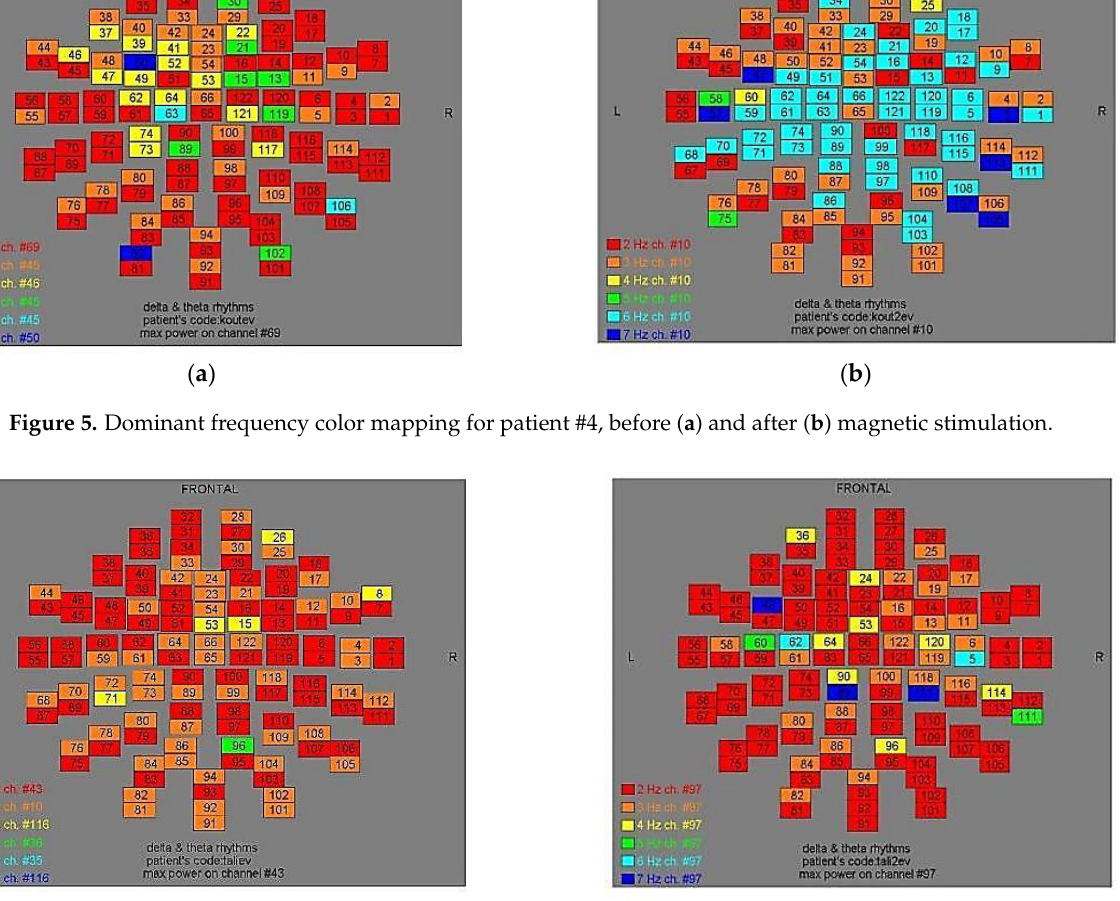
Figure 6. Dominant frequency color mapping for patient #5, before ( a ) and after ( b ) magnetic stimulation .